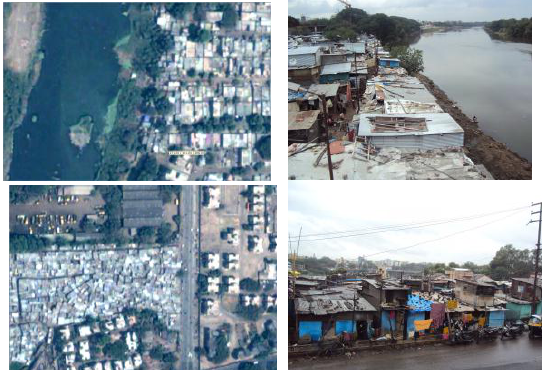
Figure 6. location of slums with field photos